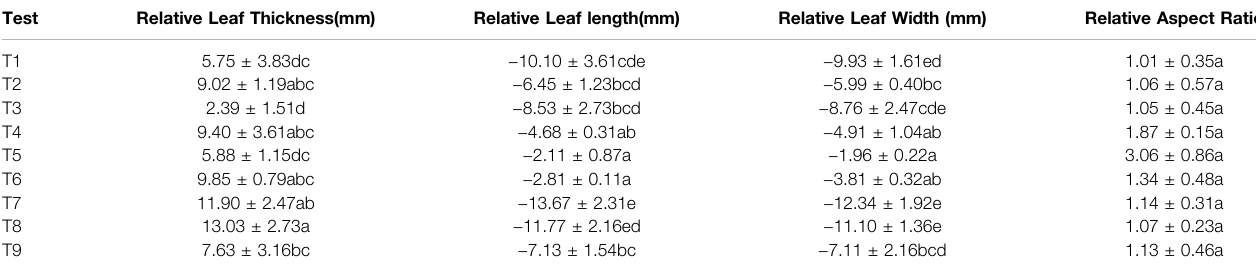
TABLE 3 | Variability analysis of the growth of morphological characteristic indexes of Elaeagnus angustifolia leaves under different regulation methods.